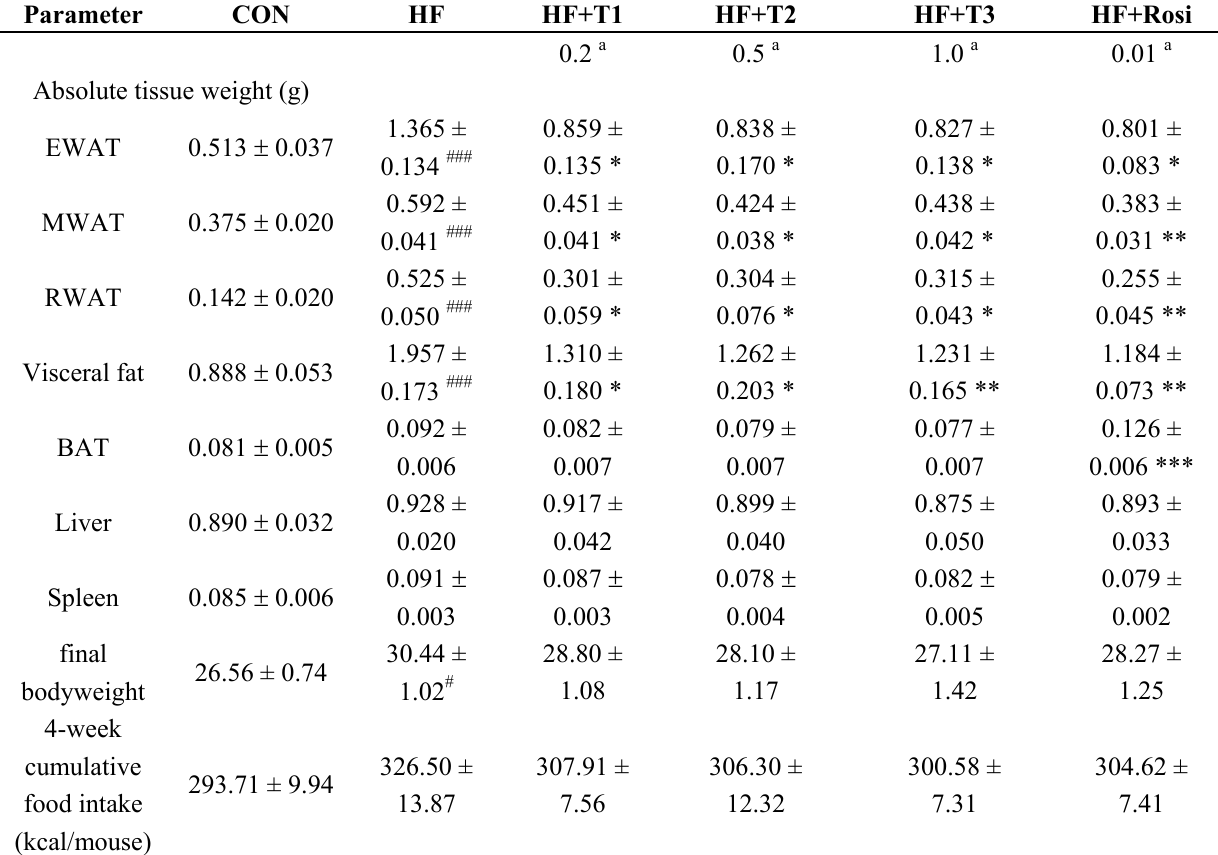
Table 1. Effects of cell suspension culture of Eriobotrya japonica on absolute tissue weight, liver lipids and blood profiles in high-fat-fed mice. All values are means ± S.E (n = 9). # p < 0.05, ### p < 0.001 compared with the control (CON) group; * p < 0.05, ** p < 0.01, *** p < 0.001 compared with the high-fat + vehicle (distilled water) (HF) group. Mice were fed with 45% high-fat diet (HF) or low-fat diet (CON) for 12 weeks. After 8 weeks, the HF mice were treated with vehicle (water), or TA, or rosiglitazone accompanied with HF diet for 4 weeks. T1, T2, T3, cell suspension culture of Eriobotrya japonica. T1, T2 and T3: cell suspension culture of Eriobotrya japonica ( T1: 0.2, T2: 0.5 and T3: 1.0 g/kg bodyweight); Rosi: rosiglitazone (0.01 g/kg body weight). BAT, brown adipose